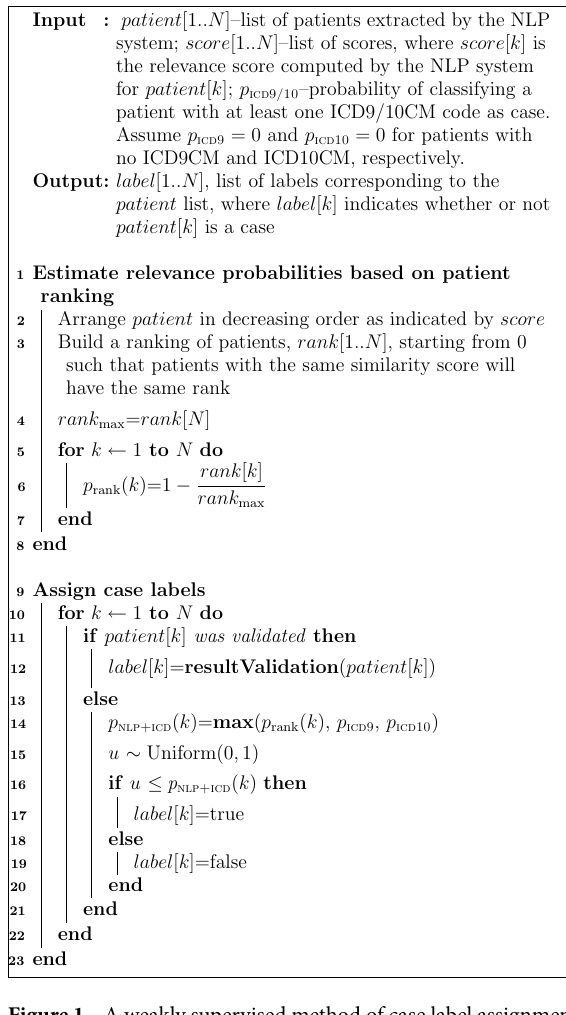
Figure 1. A weakly supervised method of case label assignment for a ranked list of patients retrieved by the NLP